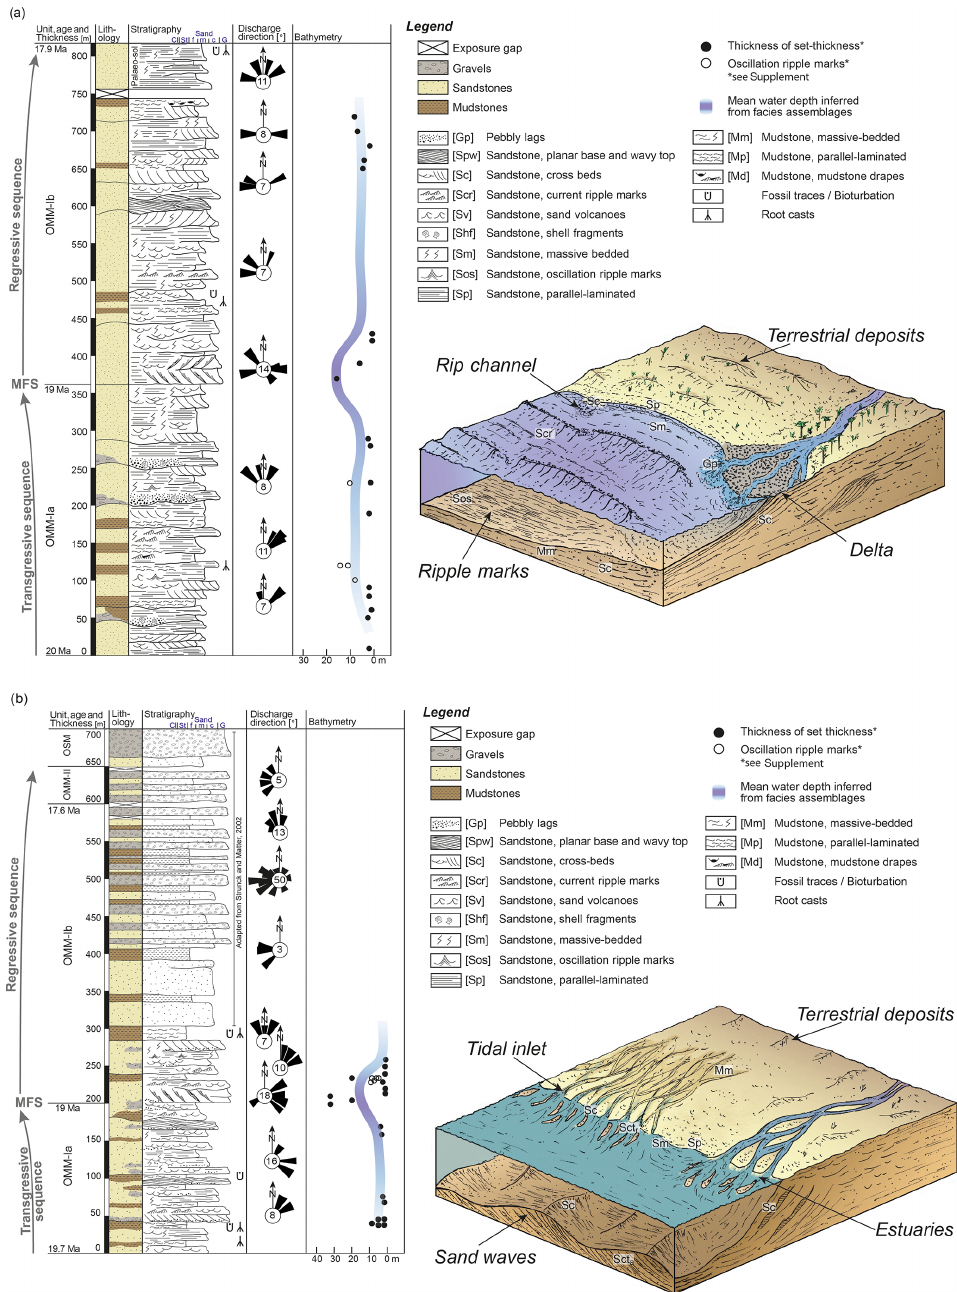
Figure 4. Sedimentological logs of (a) the Entlen and (b) the Sense section. See Fig. 2a for the locations of sections, Fig. 5 for the chrono- logical framework of the deposits, and the tables for further sedimentological details, abbreviations of the lithofacies, and references to sedimentological work. The block diagrams illustrate the palaeogeographical conditions from a conceptual point of view. Note that the palaeo-bathymetric values are minimum estimates and that the mean water depths have been inferred from the assignment of lithofacies to a depositional setting. This might explain why the numerical values for water depths based on cross-bed thicknesses and our inferred mean water depth estimates deviate between ca. 200 and 250m of the Sense